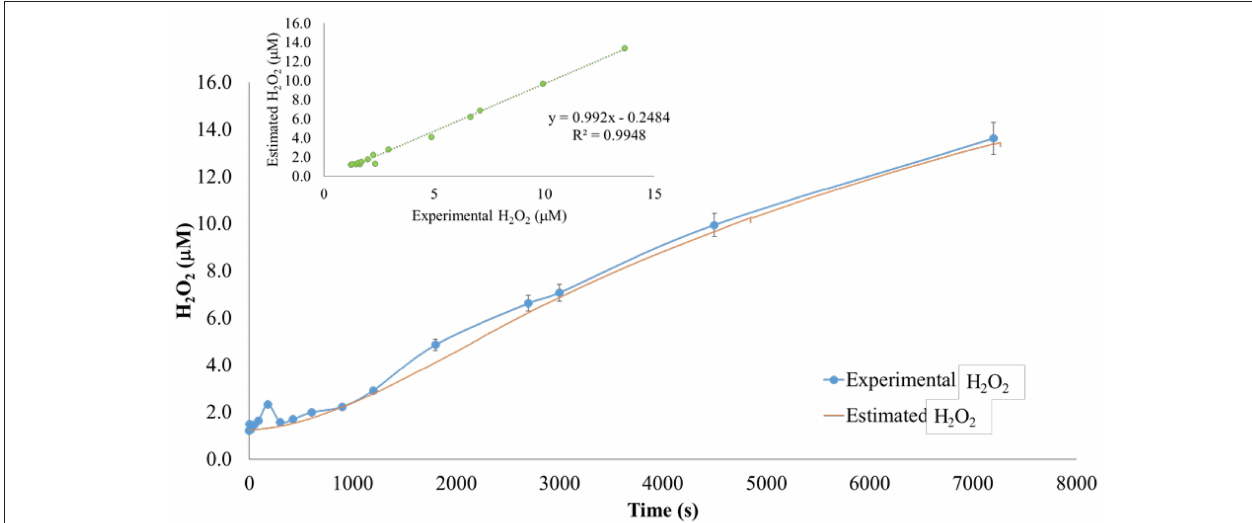
FIGURE 8 | Modeled vs. predicted hydrogen peroxide, pH 8.25. Modeled superoxide was used to predict theoretical hydrogen peroxide observed in sediment suspensions. Theoretical concentrations were compared to measured concentrations to test the conservatism of hydrogen peroxide. In marsh sediment suspensions at pH 8.25 the model predicted measured hydrogen peroxide with an r 2 = 0.992, indicating dismutation was the sink for superoxide. Better agreement between the modeled and observed data (insert) suggested the unknown peroxide sink exhibited a strong pH